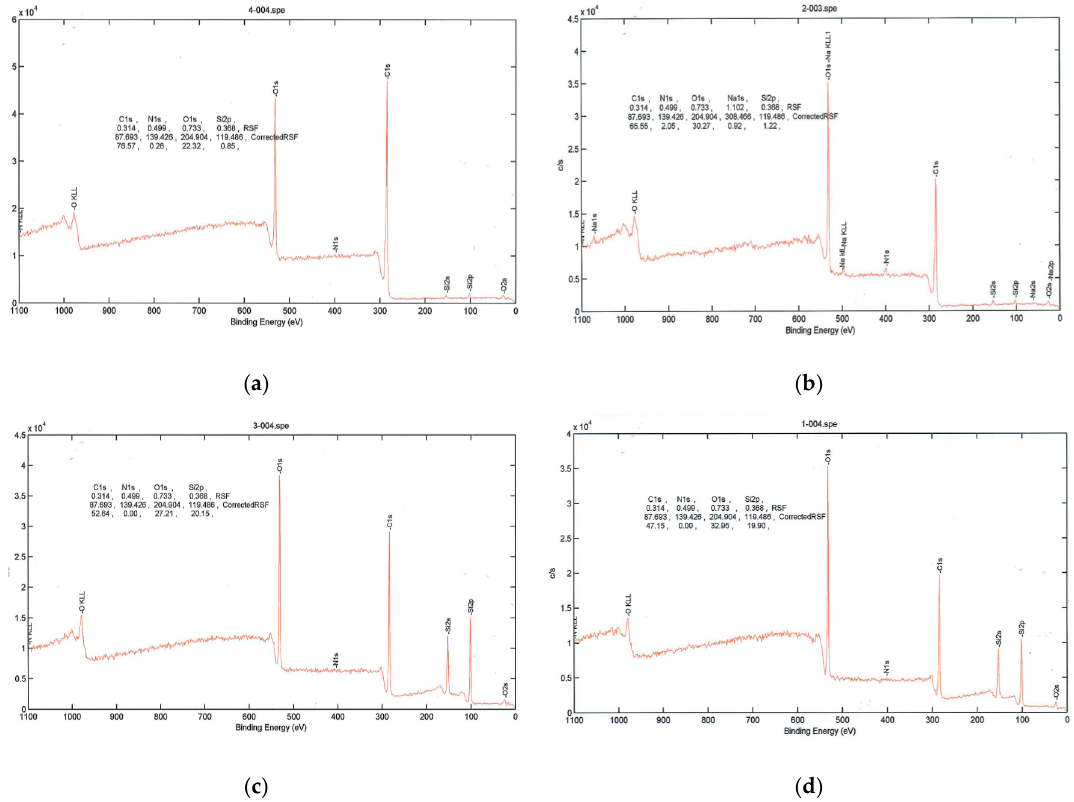
Figure 3. High-resolution X-ray photoelectron spectra. ( a ) PLA (Blank); ( b ) PLA surface plasma treatment; ( c ) PLA coated with PEG2000; ( d ) PLA coated with PEG2000 and then treated with plasma.